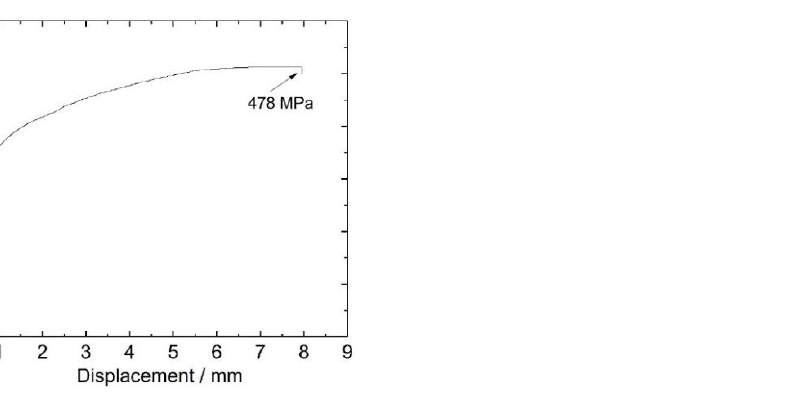
bending at room